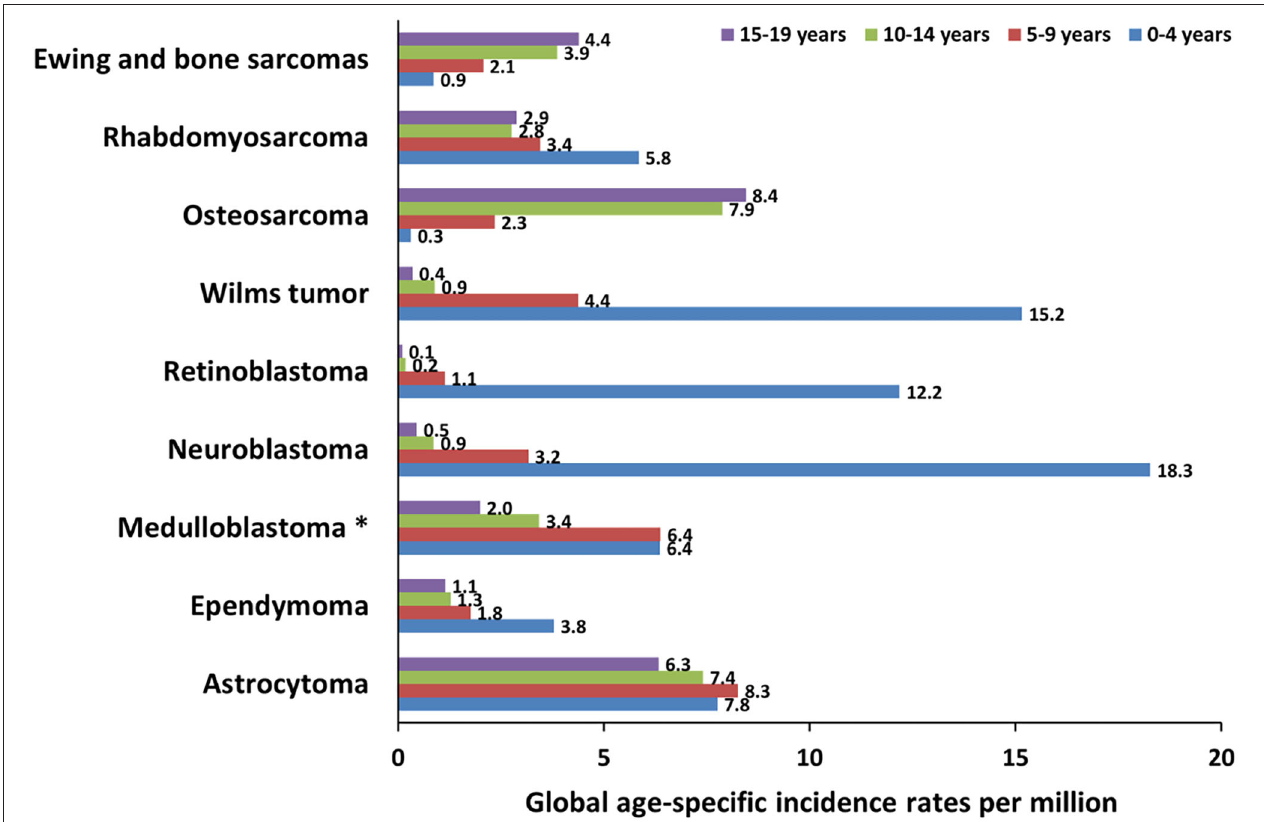
FIGURE 2 | Global incidence of pediatric cancers in patients younger than 19 years. The graph shows the global age-specific incidence rates (ASR) per million for individual age groups (0–4 years, 5–9 years, 10–14 years, and 15–19 years) of pediatric cancer types discussed in this review. ASR reported next to the bars are calculated from International Incidence of Childhood Cancer (IICC, https://iicc.iarc.fr/) data. *These ASR include also less frequent embryonal central nervous system tumors.